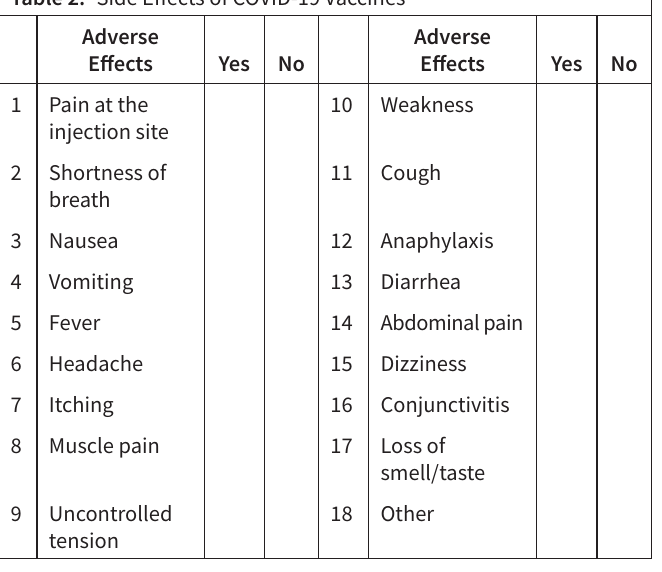
Table 3. Characteristics of Patients Classified According to Their Views of Being Vaccinated for COVID-19